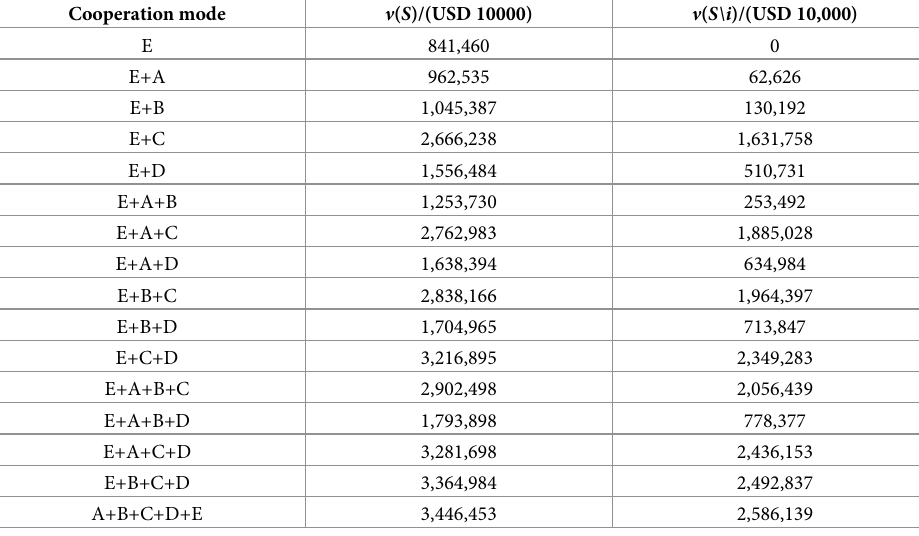
Fig 16. Comparison of profits of 16 cooperation modes between Cambodia and other four countries. https://doi.org/10.1371/journal.pone.0265350.g016 Table 11. Profits of 16 cooperation modes between Vietnam and other four